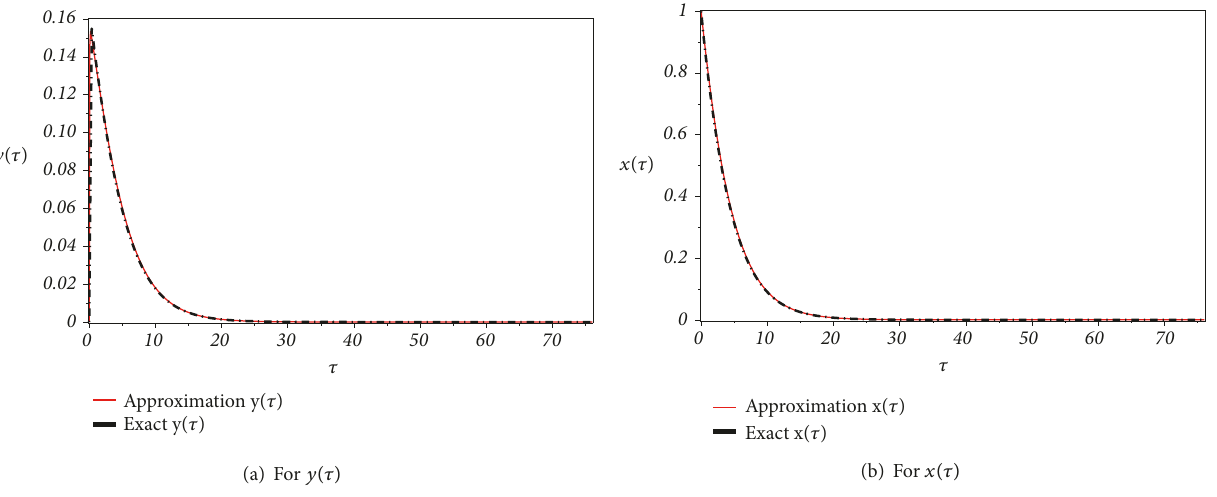
Figure 3: Comparison between numerical solutions and approximations (44).